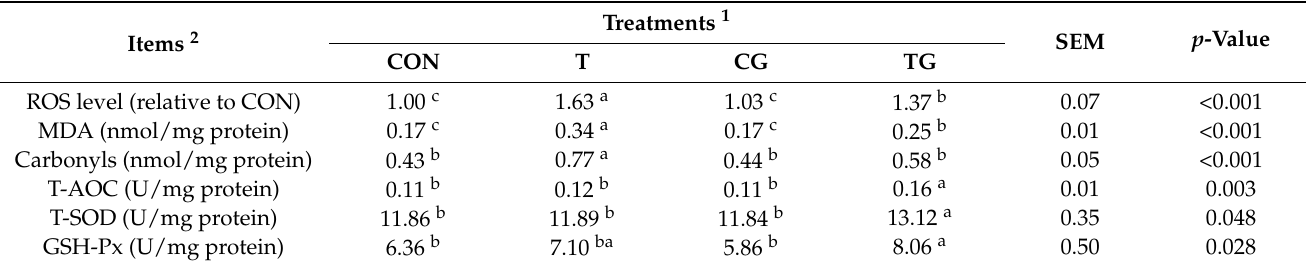
Table 2. Effects of heat shock protein 70 expression on reactive-oxygen-species production, antiox- idant capacity, and contents of oxidative products in pectoralis major muscles of broiler chickens subjected to pre-slaughter